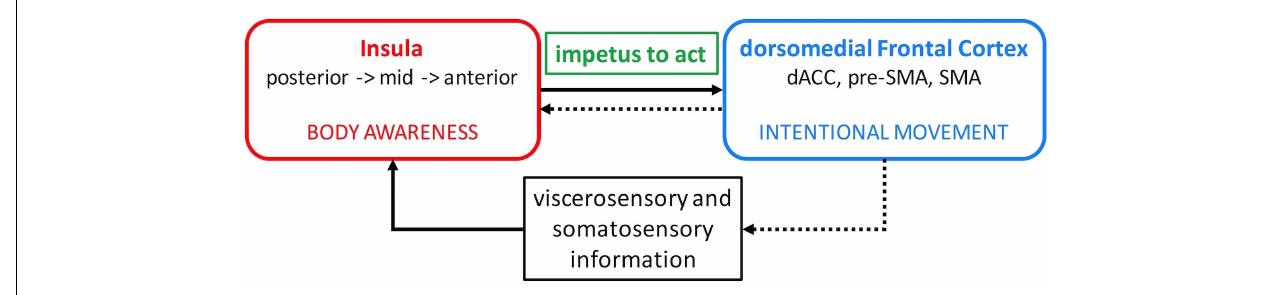
FIGURE 1 | Insula – dorsomedial frontal cortex interaction model. Viscerosensory and somatosensory afferent information is relayed to the insula where it is processed along a posterior-to-anterior axis and integrated with emotional salience and motivational potential. This elaborate information about the body is conveyed to the dorsomedial frontal cortex and generates the impetus to move (solid arrow). The insula then evaluates the outcome of the intentional movement to reinforce adaptive movements in the future (dotted arrows). dACC, dorsal anterior cingulate cortex; SMA, supplementary motor